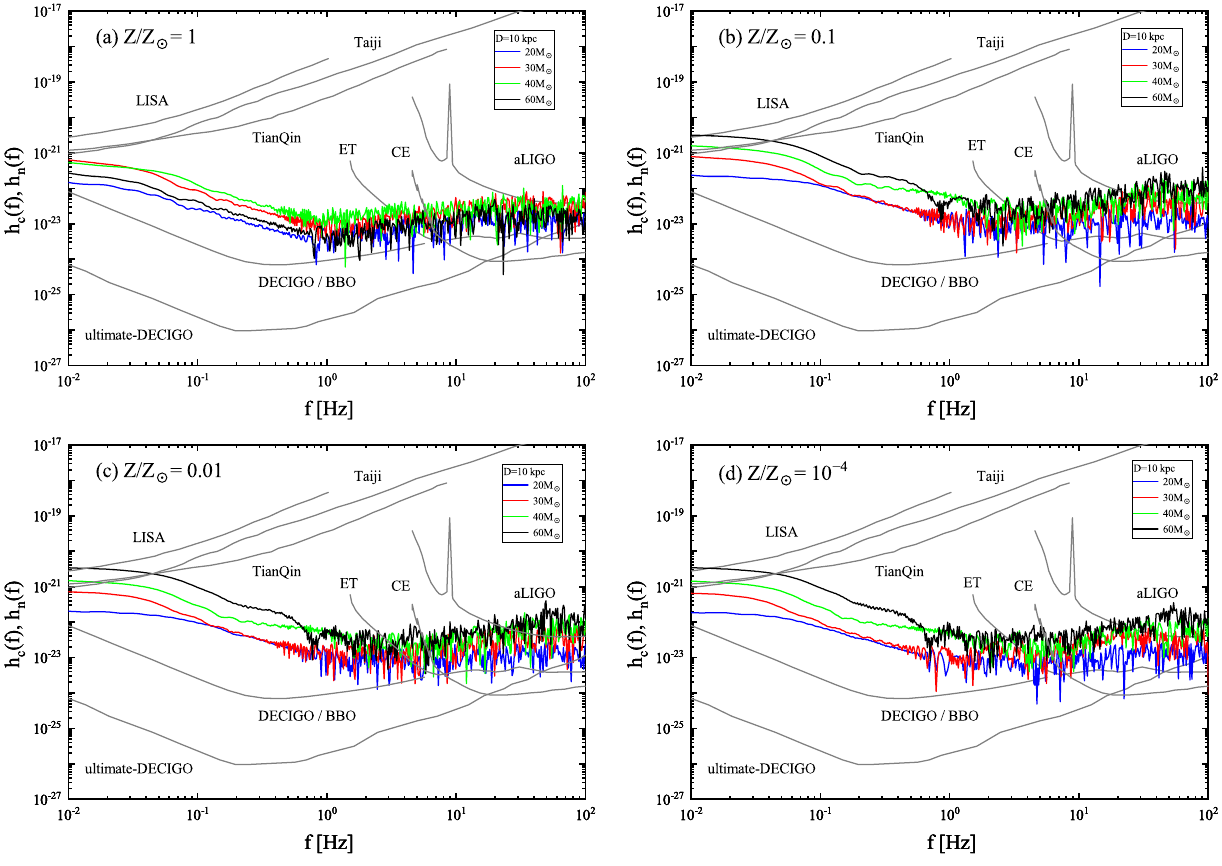
Figure 6. The strains of the GWs from NDAFs in the center of collapsars at the distance of 10 kpc. Panels ( a – d ) correspond to progenitor metallicities of Z / Z (cid:12) = 1, 0.1, 0.01, and 10 − 4 , respectively. The blue, red, green, and black curves correspond to progenitor masses of M pro / M (cid:12) = 20, 30, 40, and 60, respectively. In all four figures, the gray lines show the sensitivity lines (the noise amplitudes h n ) of aLIGO, ET, CE, LISA, Taiji, TianQin, DECIGO/BBO, and ultimate-DECIGO. (adapted with permission from Ref.